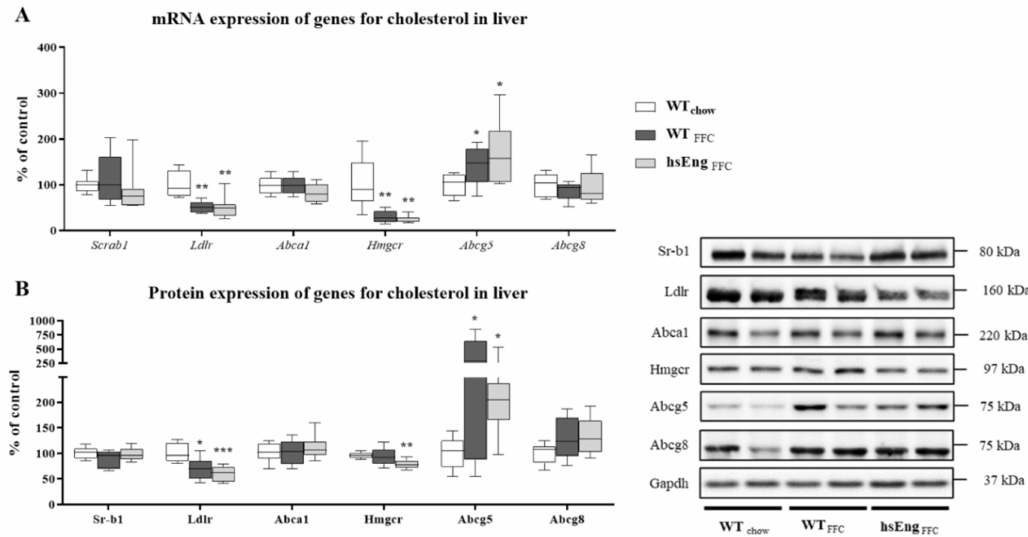
Figure 6. Cholesterol metabolism in the liver in WT and hsEng mice. mRNA ( A ) and protein ( B ) expression of intake transporter for HDL cholesterol ( Scrab1 / Sr-b1), LDL influx transporter (Ldlr), e ffl ux transporter of cholesterol to plasma (Abca1), the rate-limiting enzyme for cholesterol de novo synthesis (Hmgcr), and transporters for the elimination of cholesterol into bile (Abcg5 / Abcg8) in the liver. The data are presented as median with box and whiskers representing the interquartile range